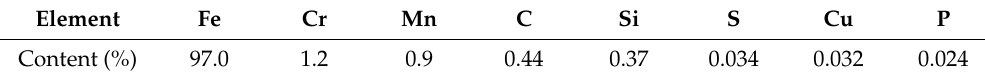
Table 2. Chemical composition of the 41Cr4 steel used for testing. Table 1. Chemical composition of the AlCuMg2 alloy used for testing.